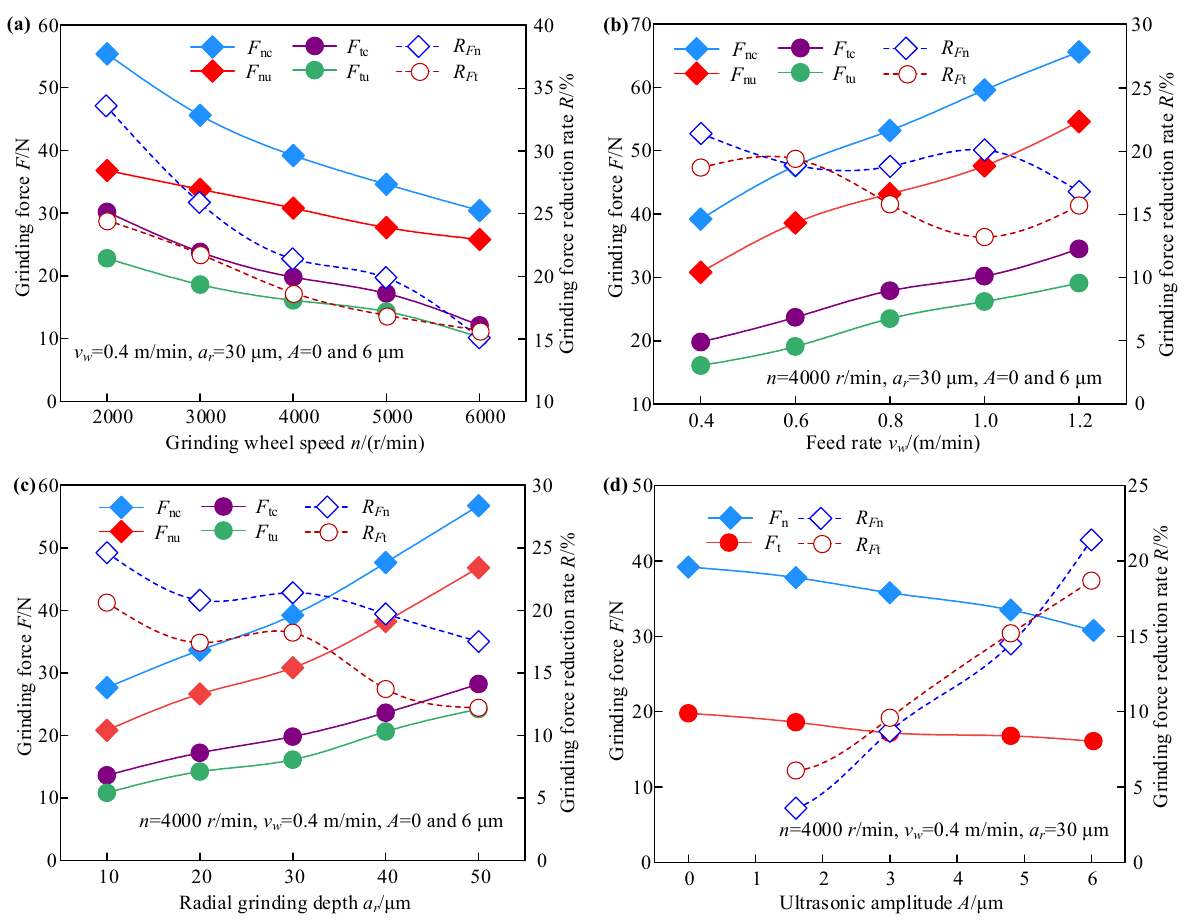
Figure 2. Effects of processing and ultrasonic parameters on the grinding force: ( a ) grinding wheel speed, ( b ) feed rate, ( c ) radial grinding depth, and ( d ) ultrasonic amplitude.